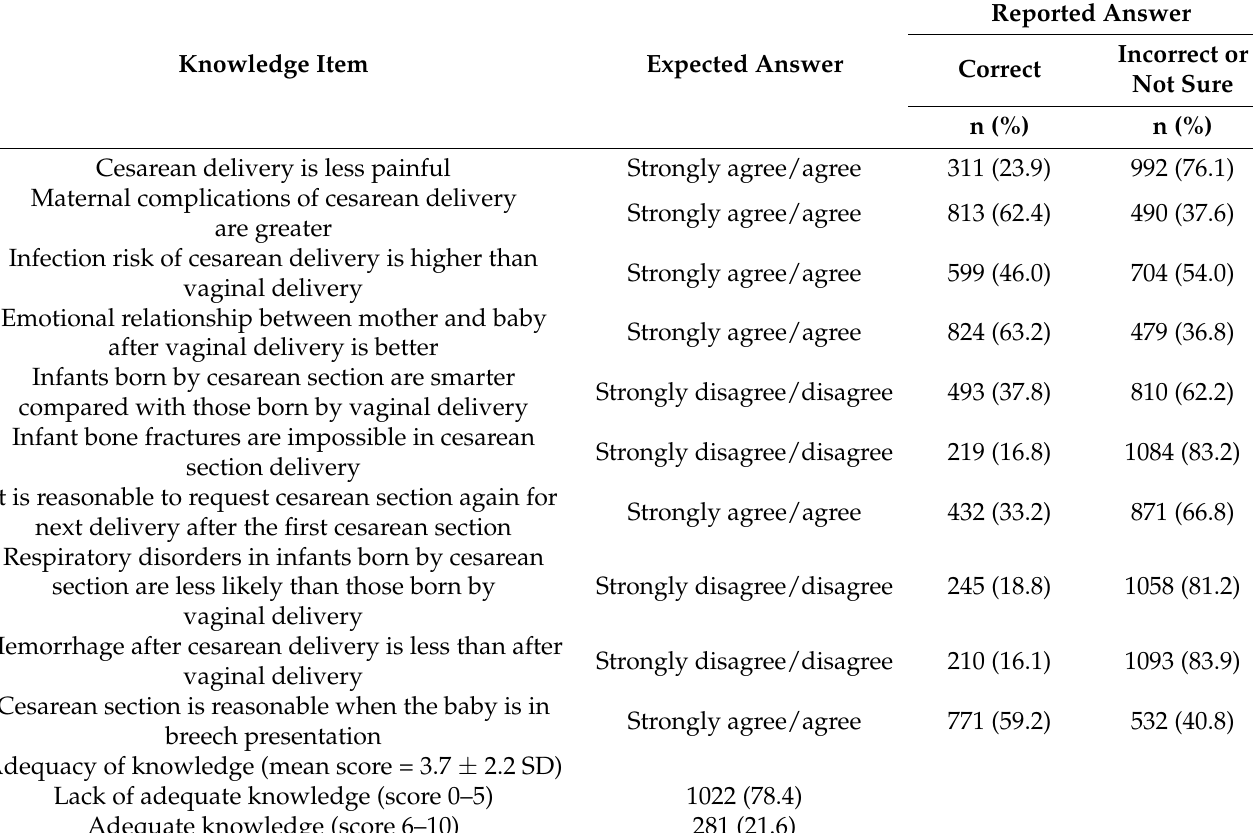
Table 2. Measured maternal knowledge using the ten knowledge-based statements inquiring about the mode of